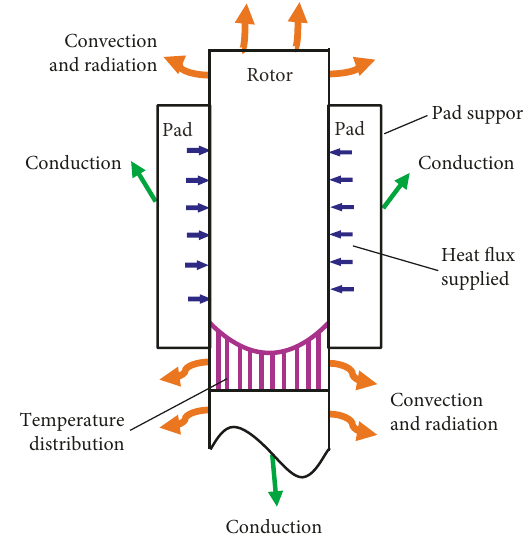
Figure 2: Heat transfer mechanism in disc brake system.